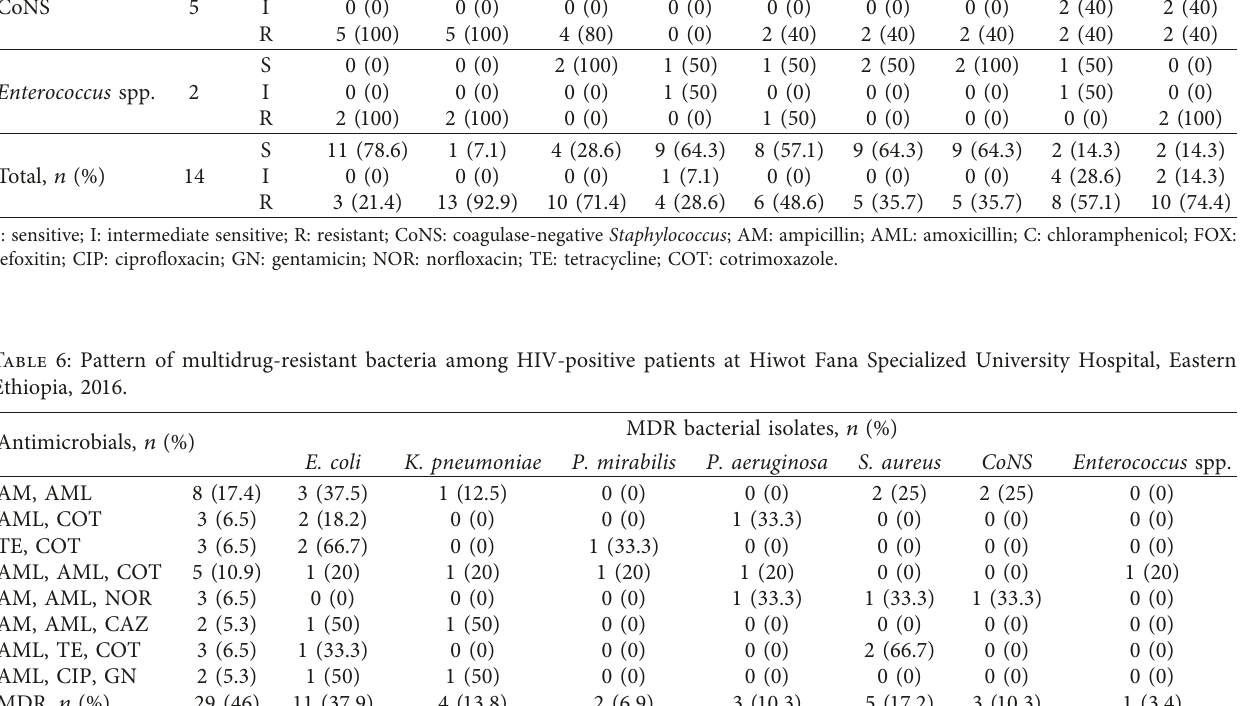
Table 5: Antimicrobial susceptibility pattern of Gram-positive bacterial isolates to antimicrobial agents among HIV-positive patients at Hiwot Fana Specialized University Hospital, Eastern Ethiopia, 2016. Bacterial isolates, n